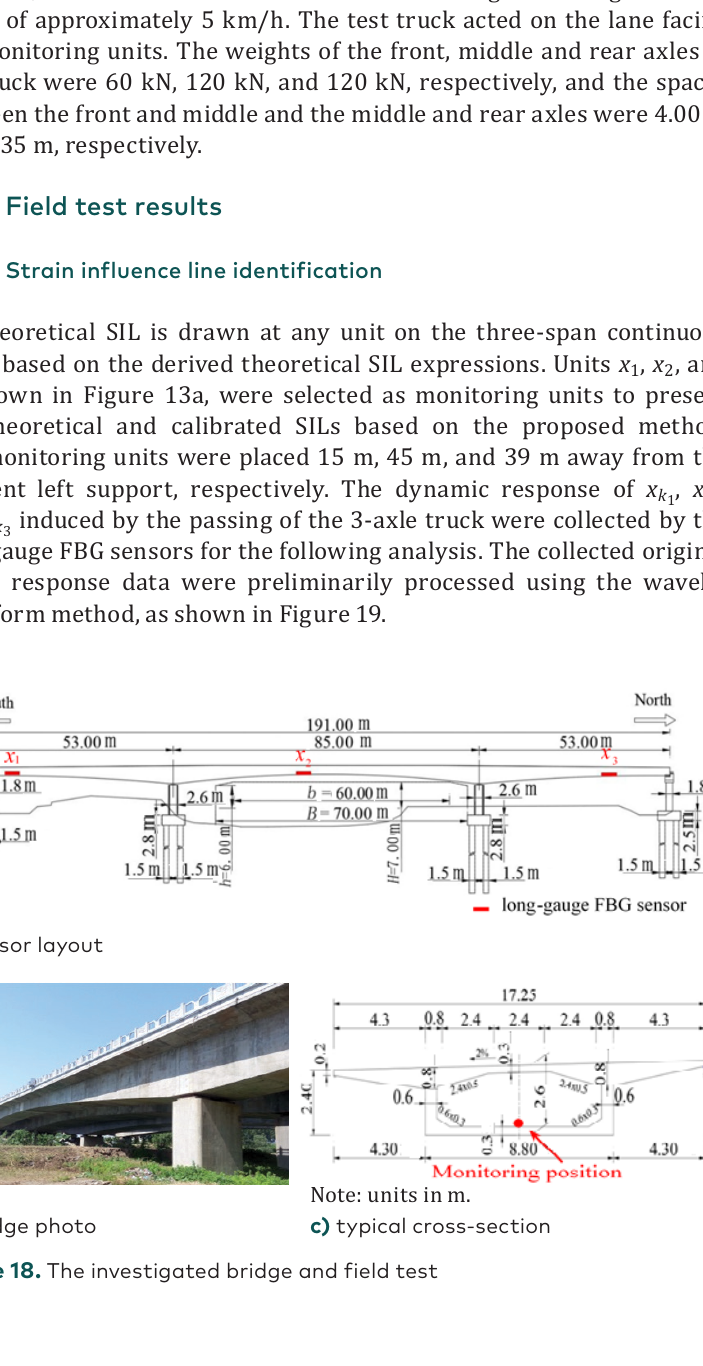
Figure 18. The investigated bridge and field test